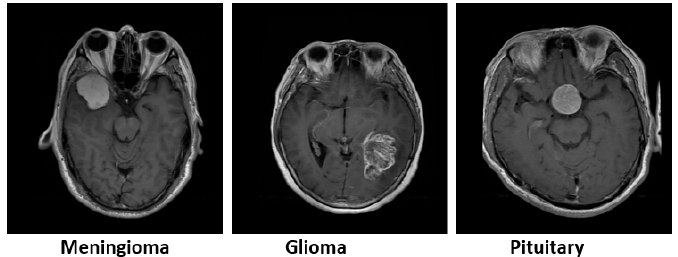
Figure 6. Axial brain tumor images from the public dataset provided by Jun Cheng et al.